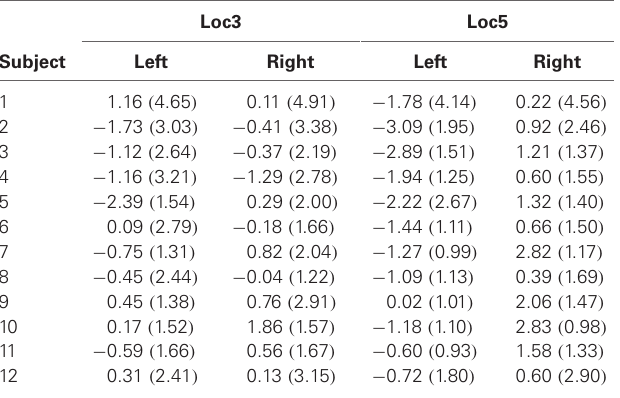
Table 2 | Mean (SD) reaching endpoints relative to control condition for every participant in the loc3 and loc5 condition, split up by the direction of the allocentric shift .